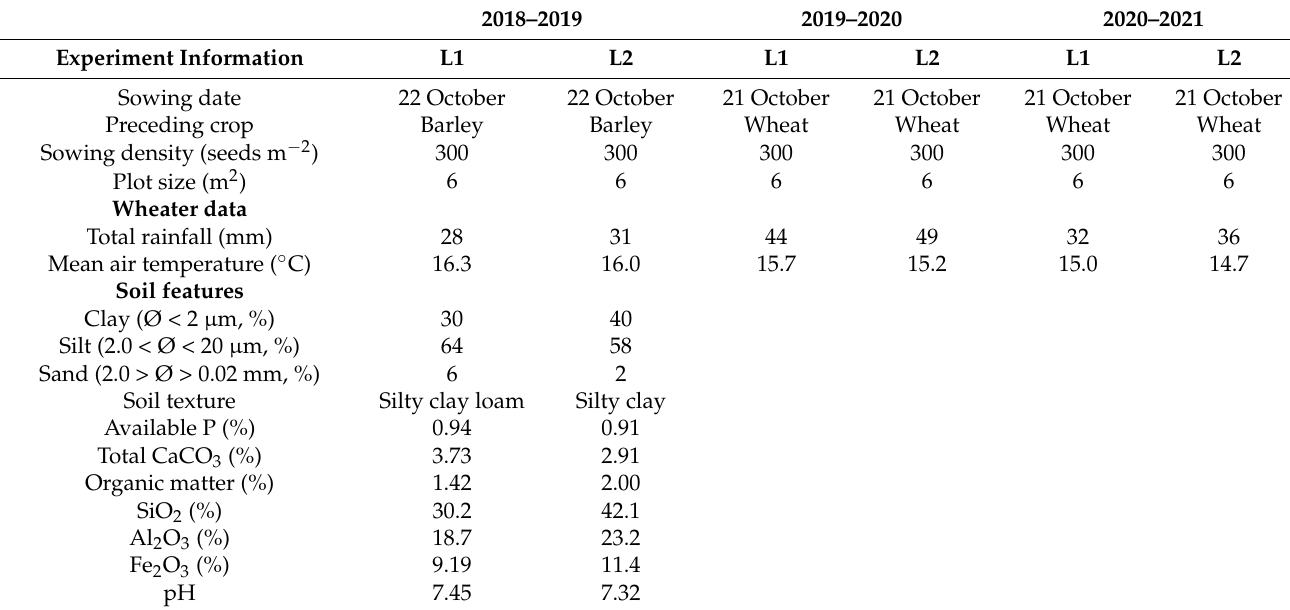
Table 1. Description of experimental seasons and